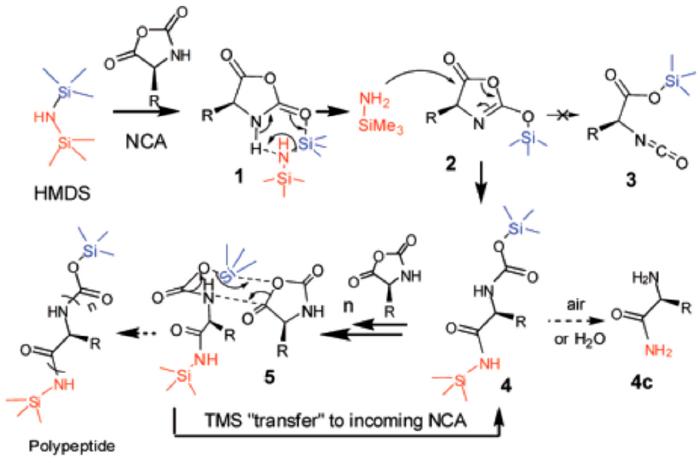
Figure 14. Hexamethyldisilazane (HMDS)-mediated NCA polymerization through trimethylsilyl (TMS) carbamate group. Reproduced with permission from reference [72,73].